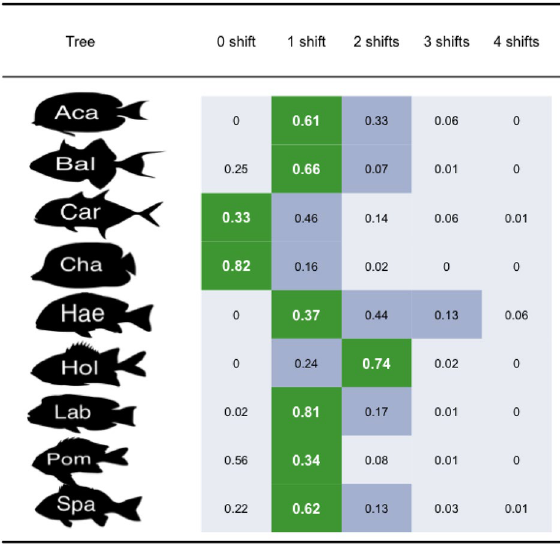
Table 1. Models selected by the TreePar analysis. For each phylogeny, the cell in green represents the optimal number of shifts estimated on the consensus tree; The cells in dark grey represent the models based on the consensus tree that have a (cid:31) AICc lower than two and the cells in light grey represent the models based on the consensus tree, that are rejected by the AICc approach. The proportions represent the frequency of selection of each model in the posterior distributions with the AICc approach. Aca Acanthuridae, Bal Balistoidea, Car